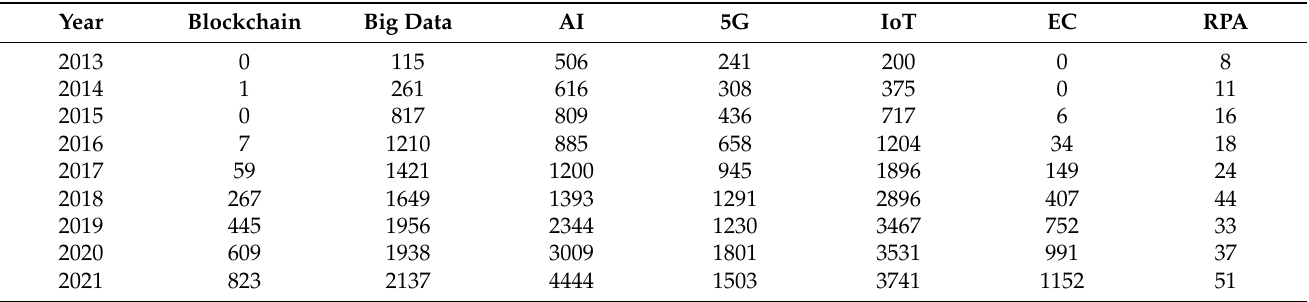
Table 1. The results of the bibliometric analysis of publication number on CE technologies in the energy